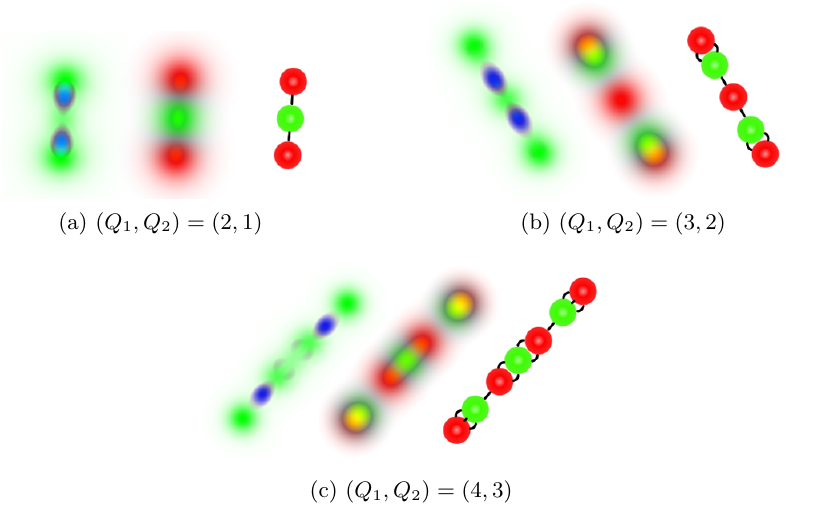
Figure 6 : ( Q 1 ; Q 2 ) = ( Q + 1 ; Q ) vortex \sticks", with Q = 1 ; 2 ; 3. Each sub(cid:12)gure contains 3 elements from left to right: an energy density plot, a (cid:12)eld density plot and a sketch of how the red and green vortices are interconnected. The (cid:12)rst two plots are made using the coloring scheme of (cid:12)gure